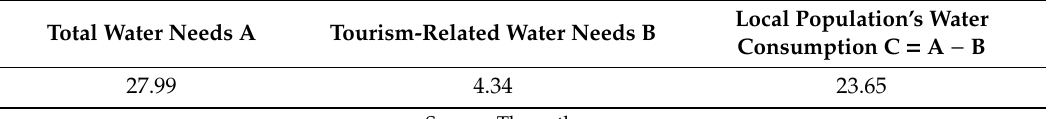
Table 7. Estimation of local consumption (hm 3 / year),